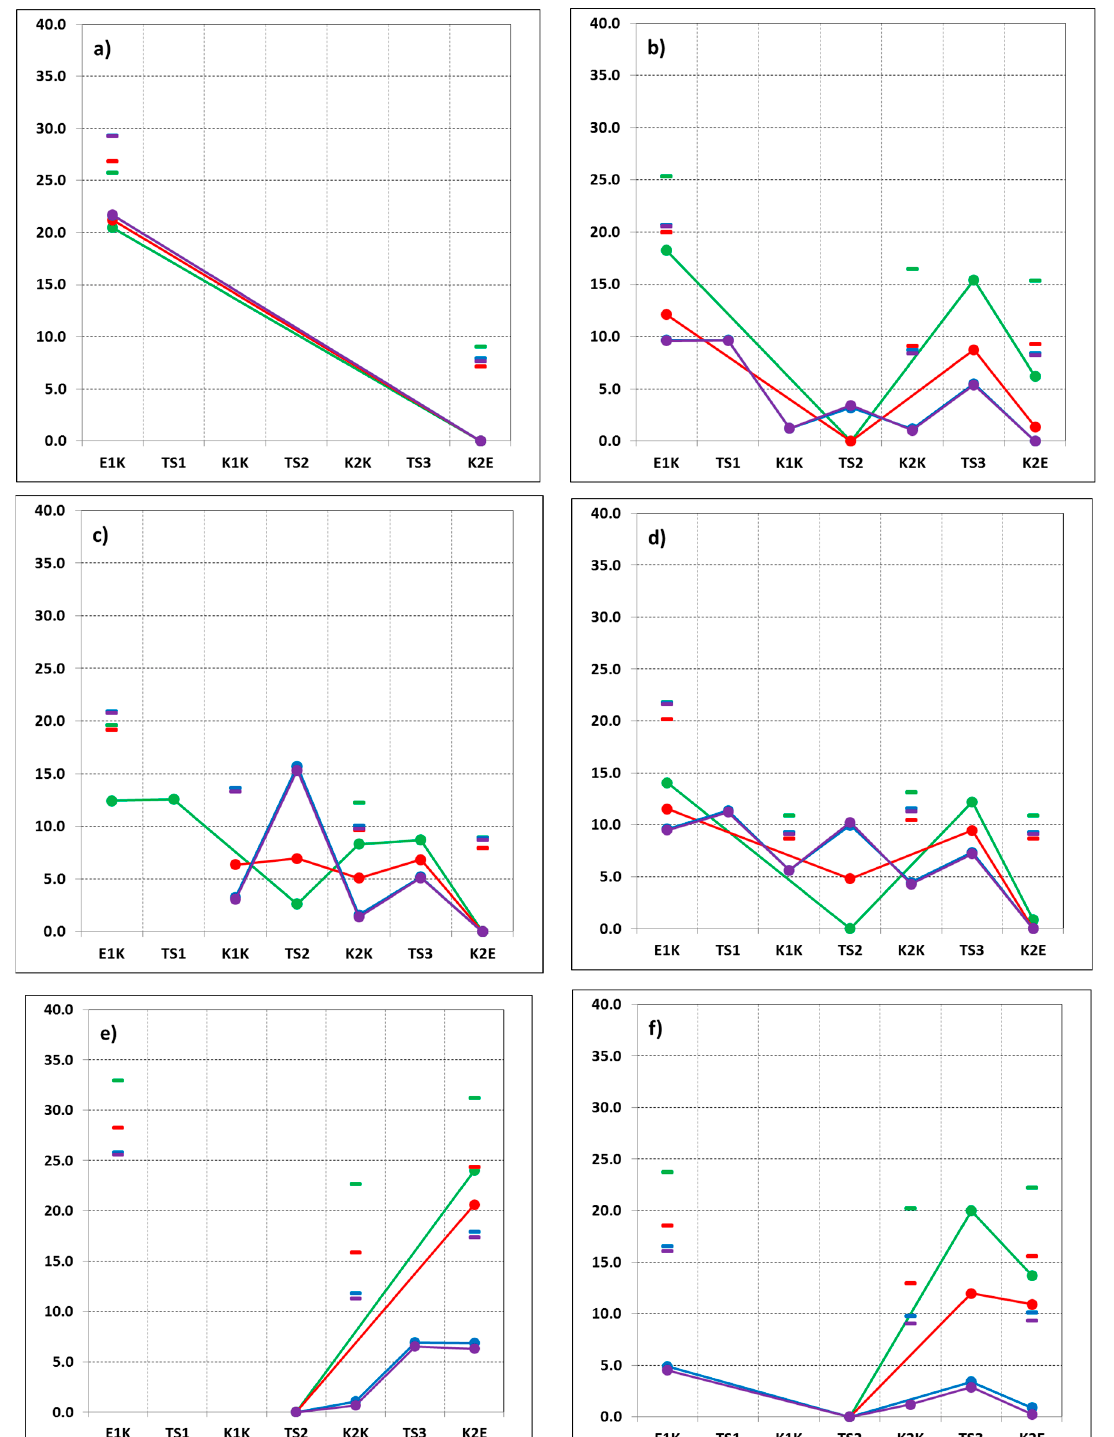
Figure 2. Excited (S 1 ) state energy landscape (relative energies in kcal / mol units) of 4 – 7 ( a – d )) and 11 – 12 ( e , f ) in vacuum (green), toluene (red), acetonitrile (blue) and formamide (violet). The filled circles represent optimized structures. The corresponding vertical transitions are given in dashes.